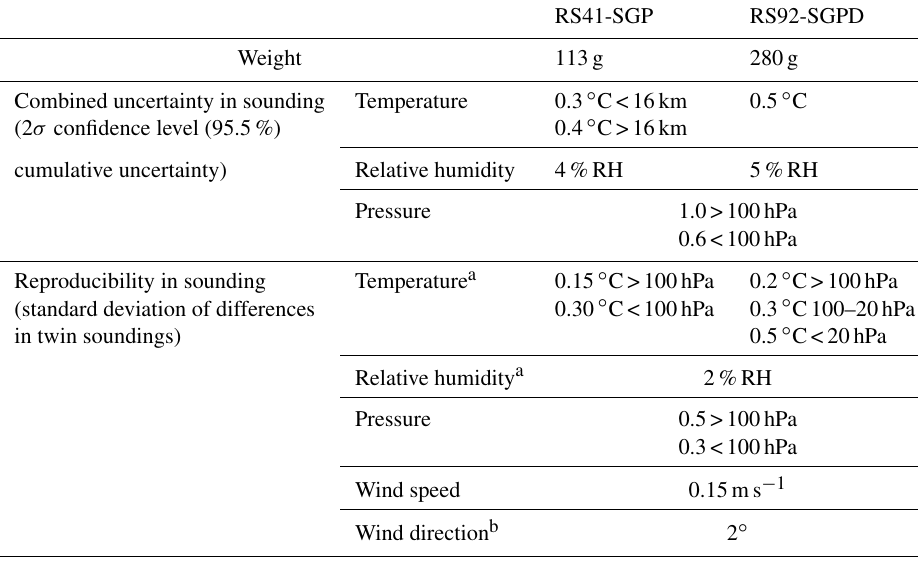
Table 1. Nominal accuracies of the radiosondes according to the